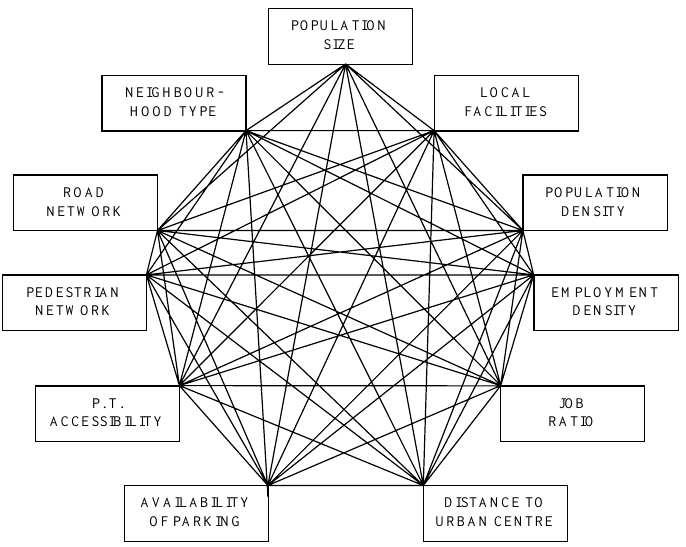
Figure 4. Interactions between land use characteristics The ability to relate travel behaviour with particular neighbourhood or network types is problematic. For a start, the terminology used is not standard, leading to use of descriptions of neighbourhoods or street patterns which may be ambiguous or otherwise not easily interpretable. Terms such as ‘clear’ or ‘coherent’ or ‘connected street networks’ are used to characterise street pattern, but their precise meaning is not always clear (Marshall,